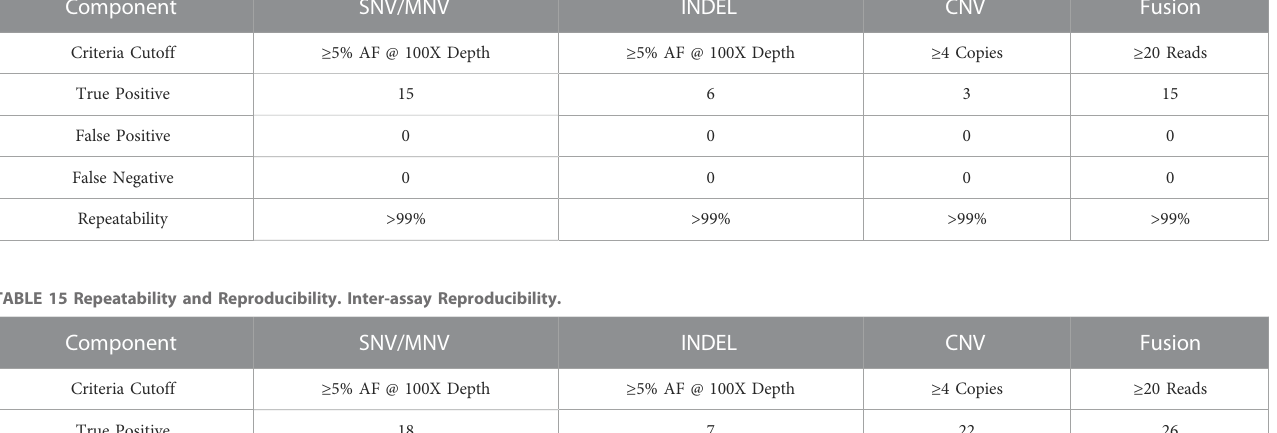
TABLE 14 Repeatability and Reproducibility. Intra-assay Repeatability. Component Criteria Cutoff